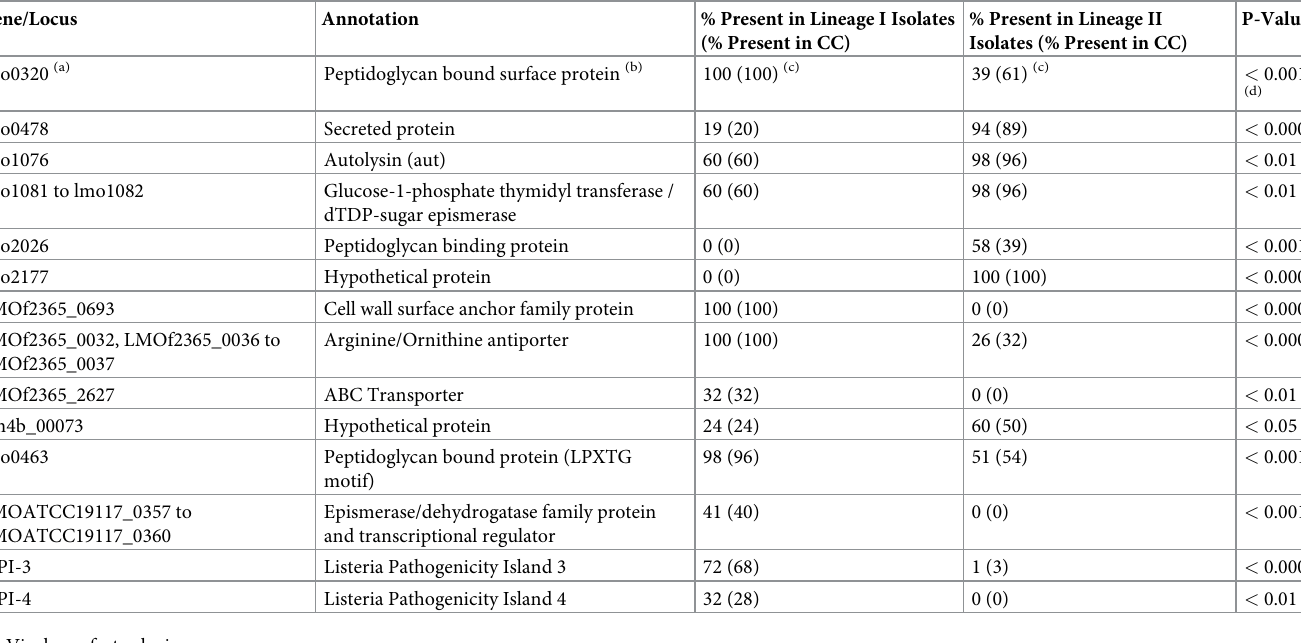
Table 2. Virulence factors that were more frequently detected in one lineage than the other (lineages I and